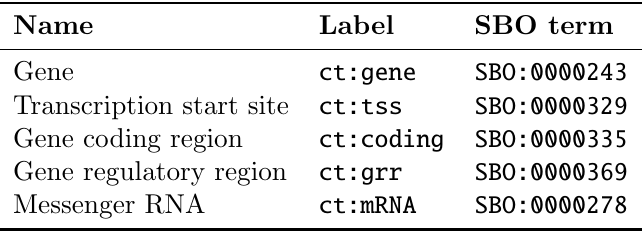
Table 2.3: A sample of values from the conceptual types vocabulary (Section